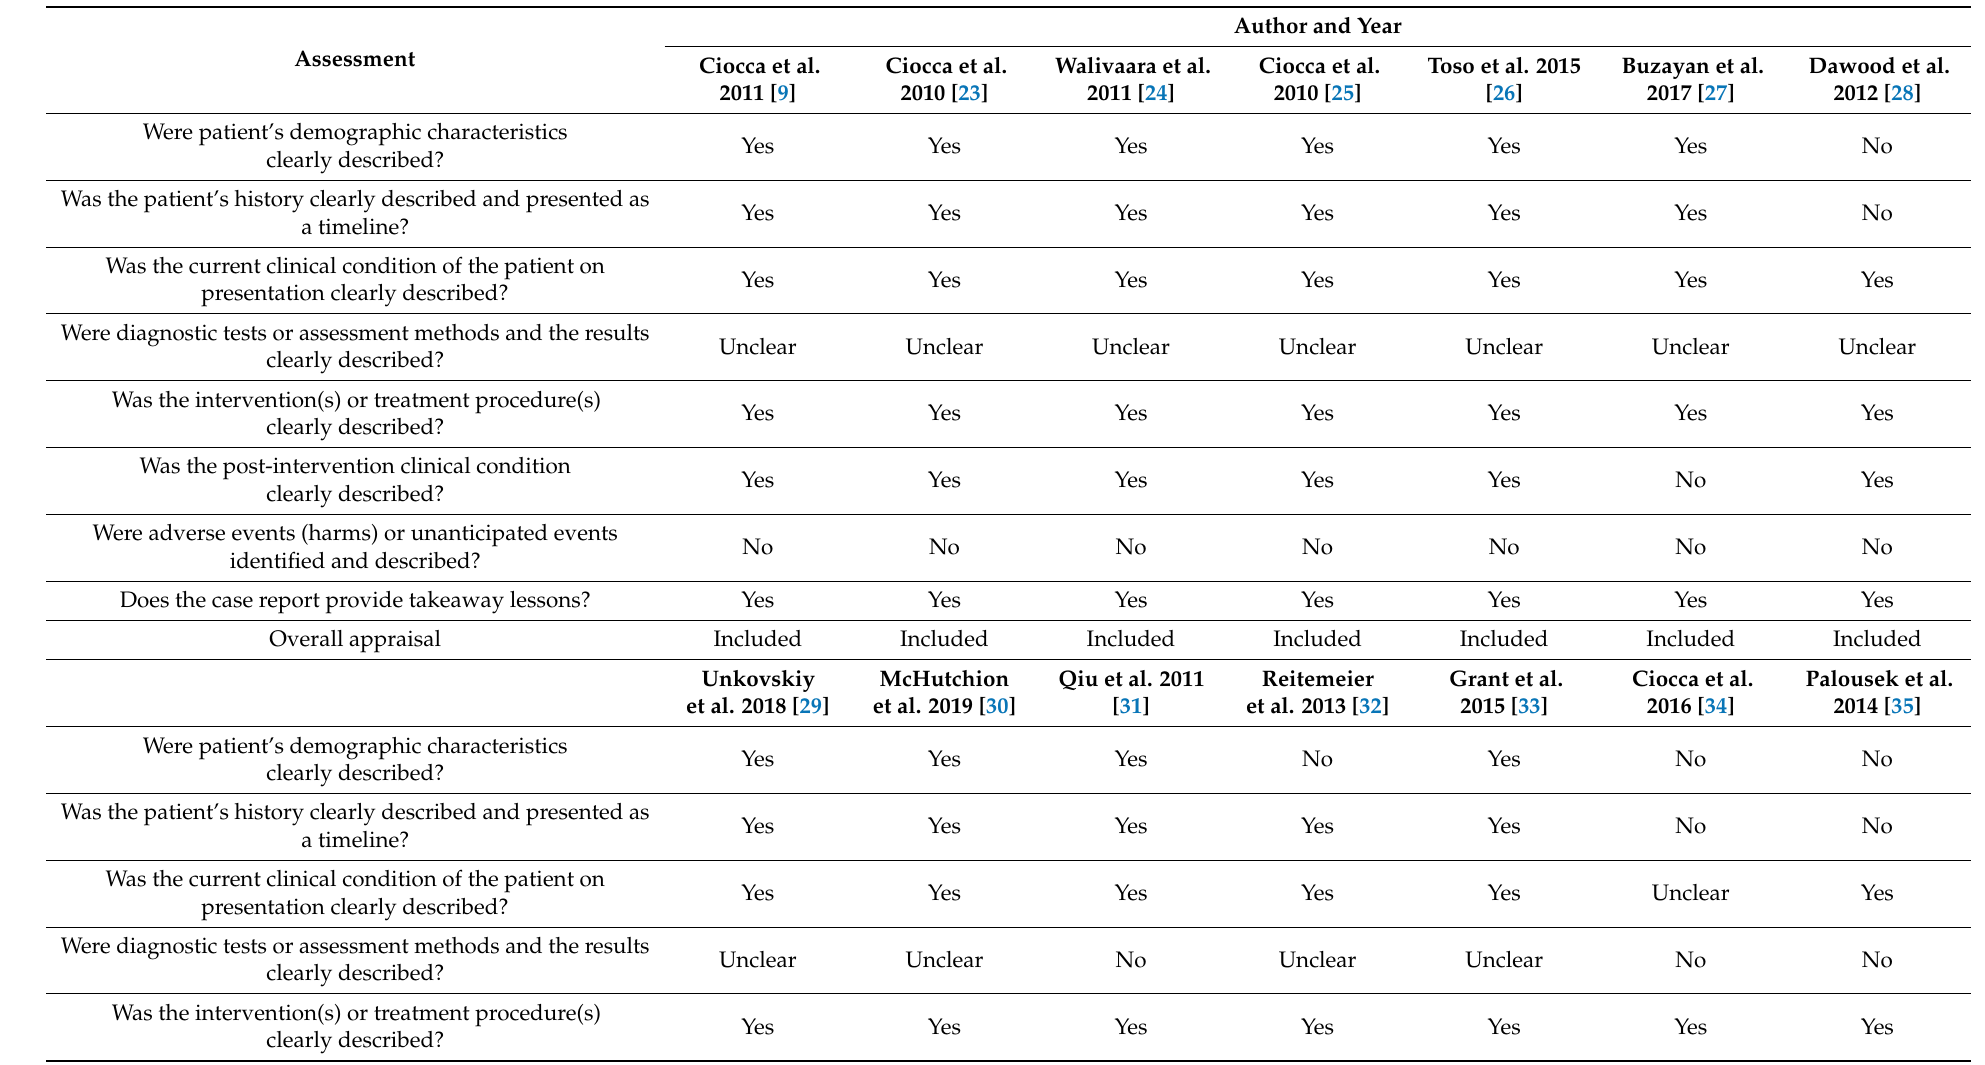
Table 2. Risk of bias for case